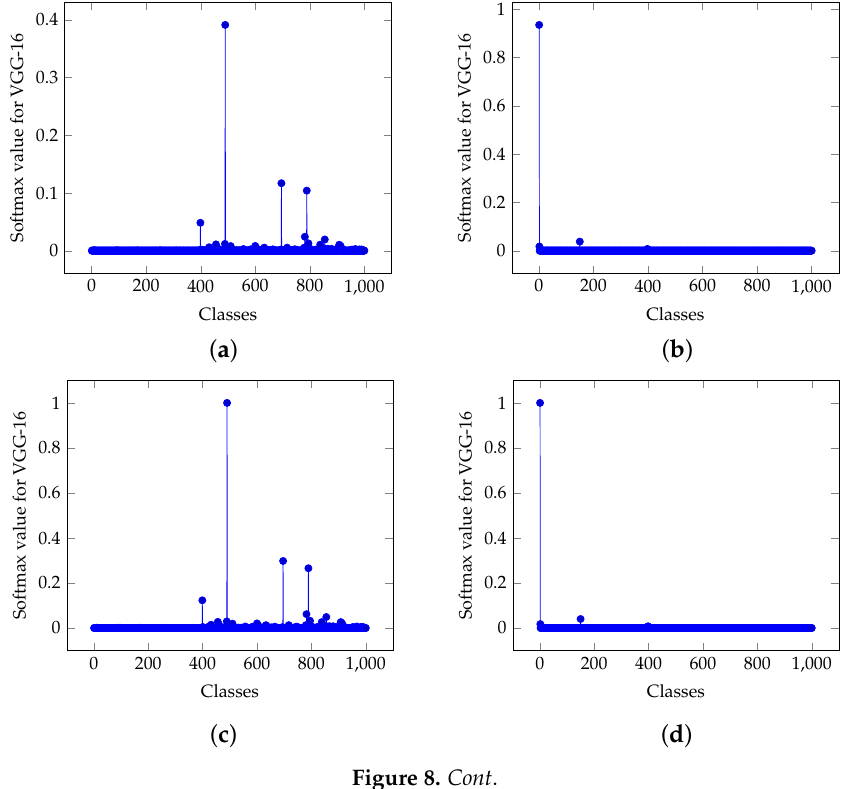
(c) Proposed approximation softmax values for inference A based on architecture of Fig. 2a and (18).